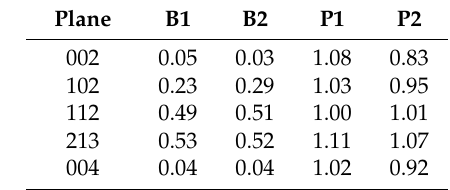
Table 6. Values of textural degree index DR (%).